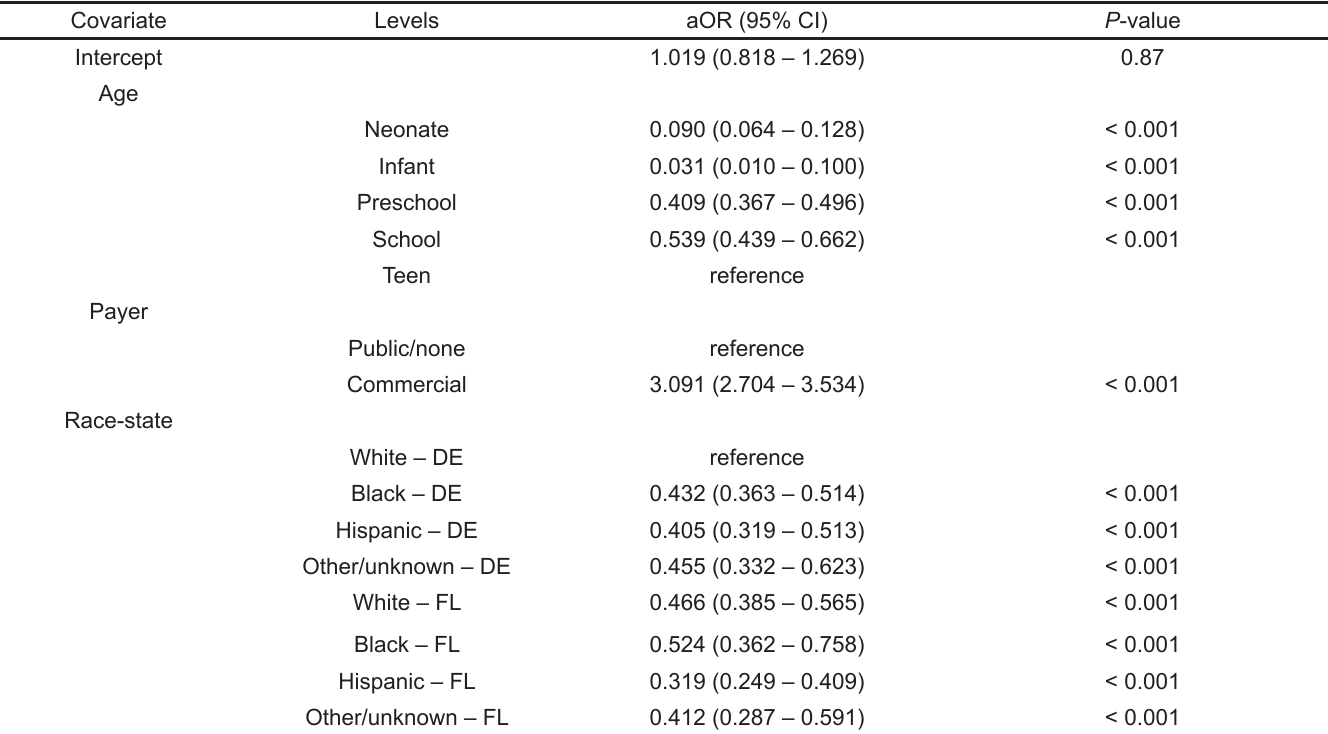
Table 3b. Multinomial logistic regression modeling the probability of “emergent”